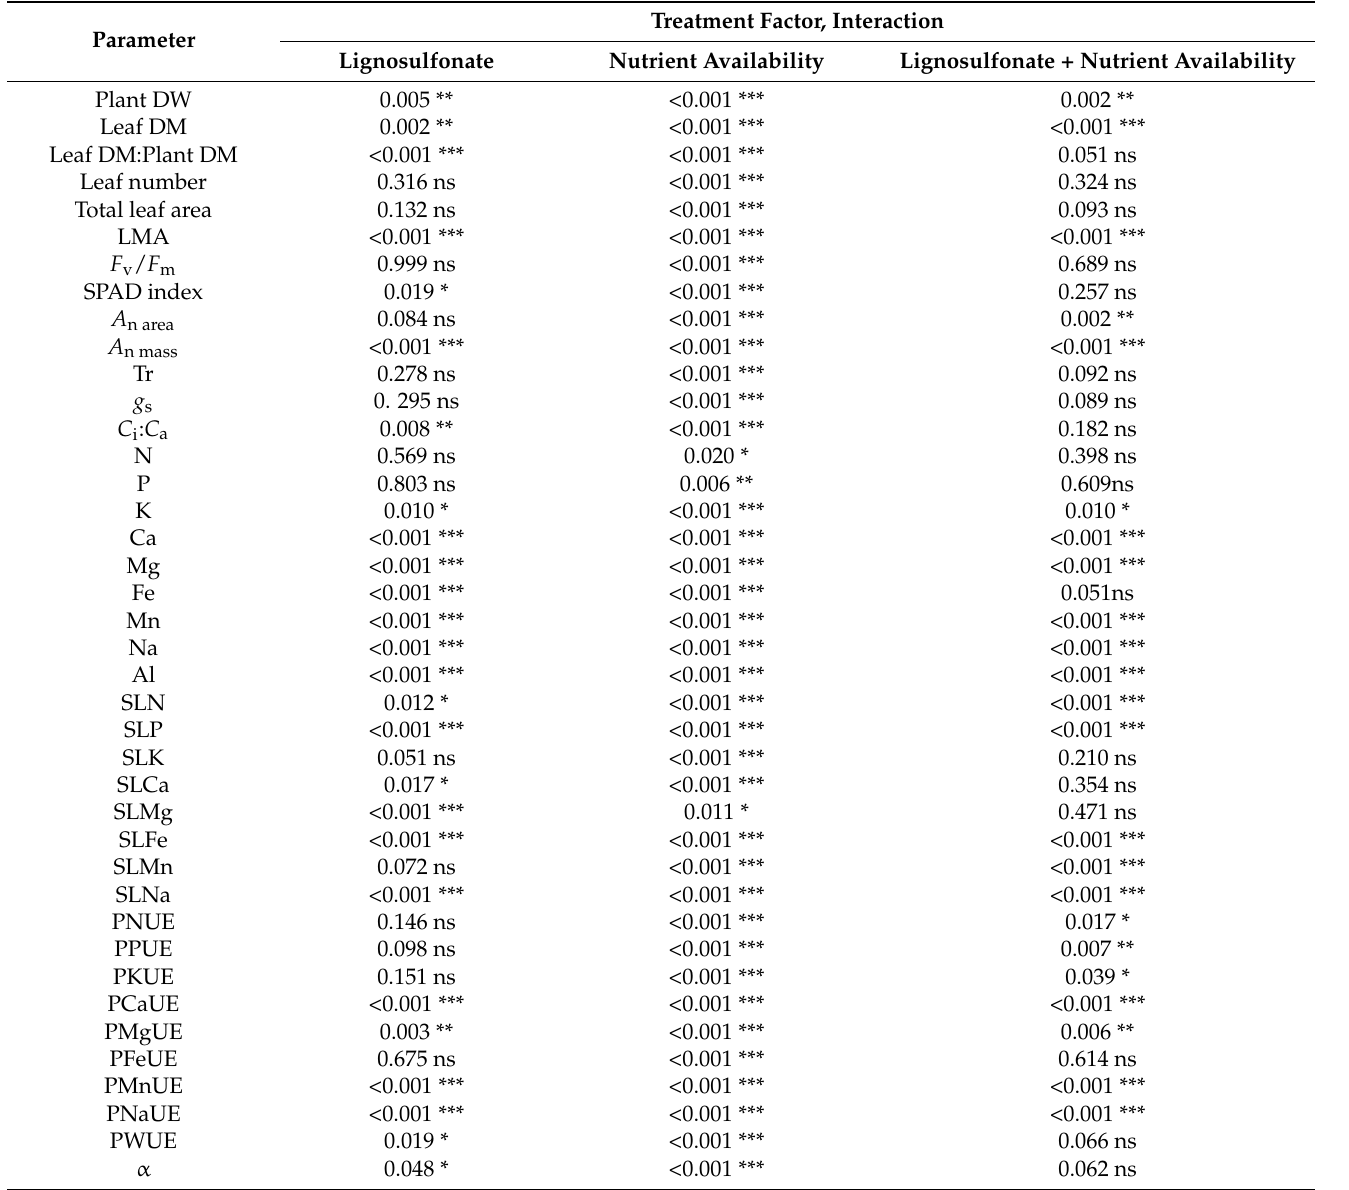
Table 4. Statistical results ( p ) of TWO-WAY